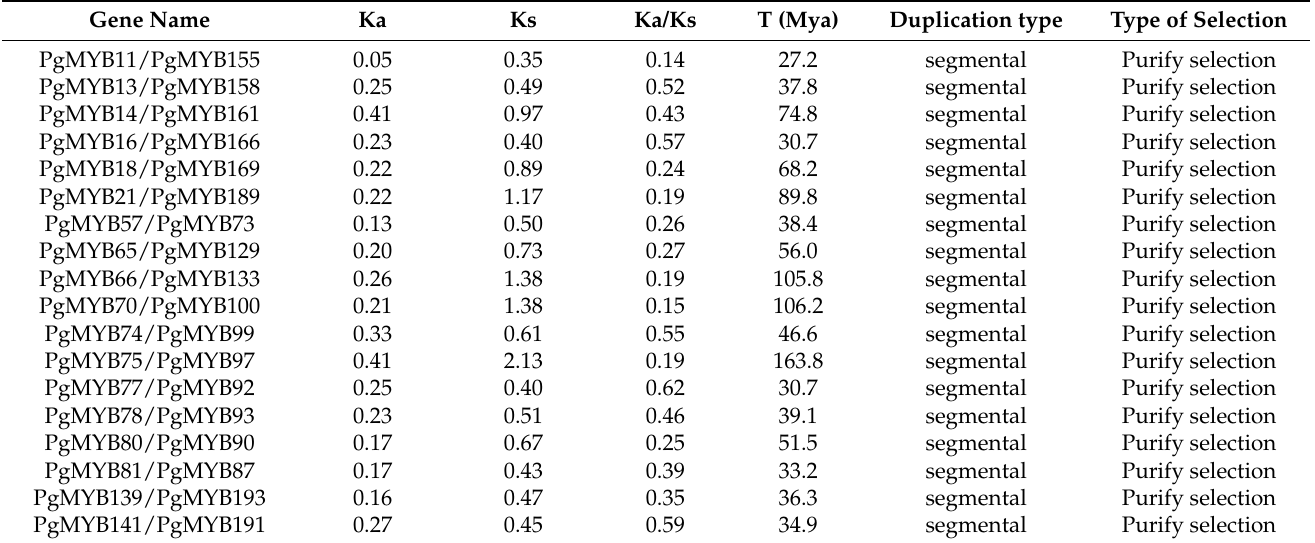
Table 1. Ka/Ks analysis and predicted divergence time of PgMYB